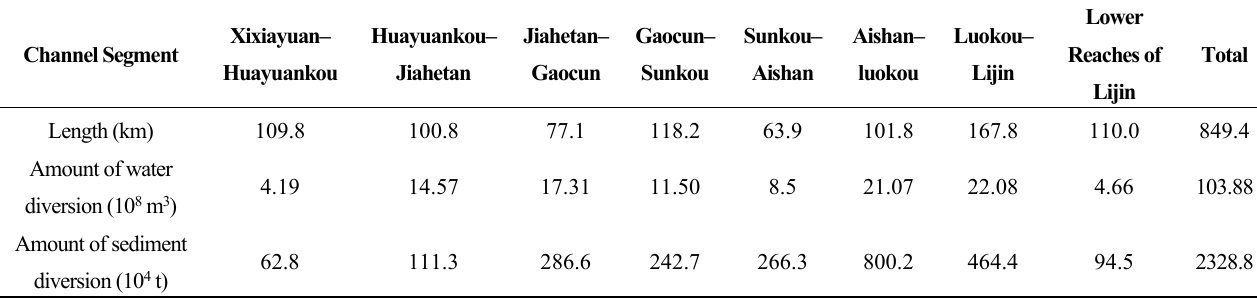
Table 6. Amount of water and sediment diversion in the downstream reaches of the Yellow River in